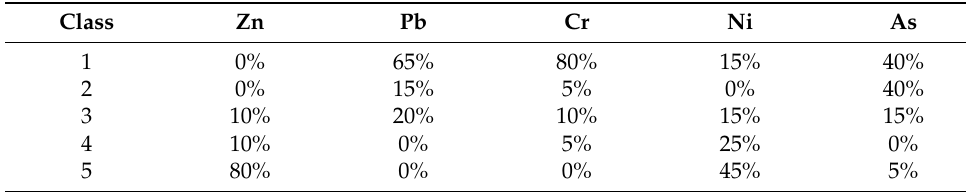
Table 3. Class distribution of p -value for heavy metals.